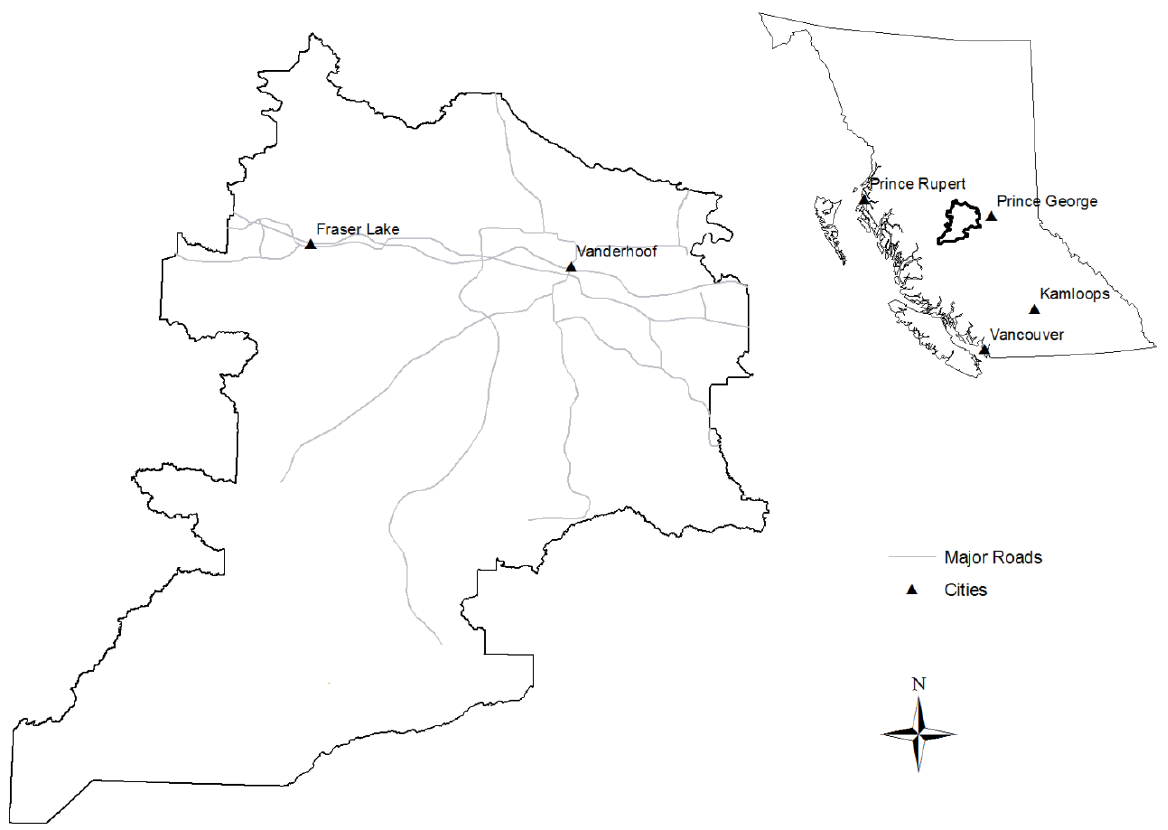
Figure 1. Location of the Vanderhoof Forest District in British Columbia